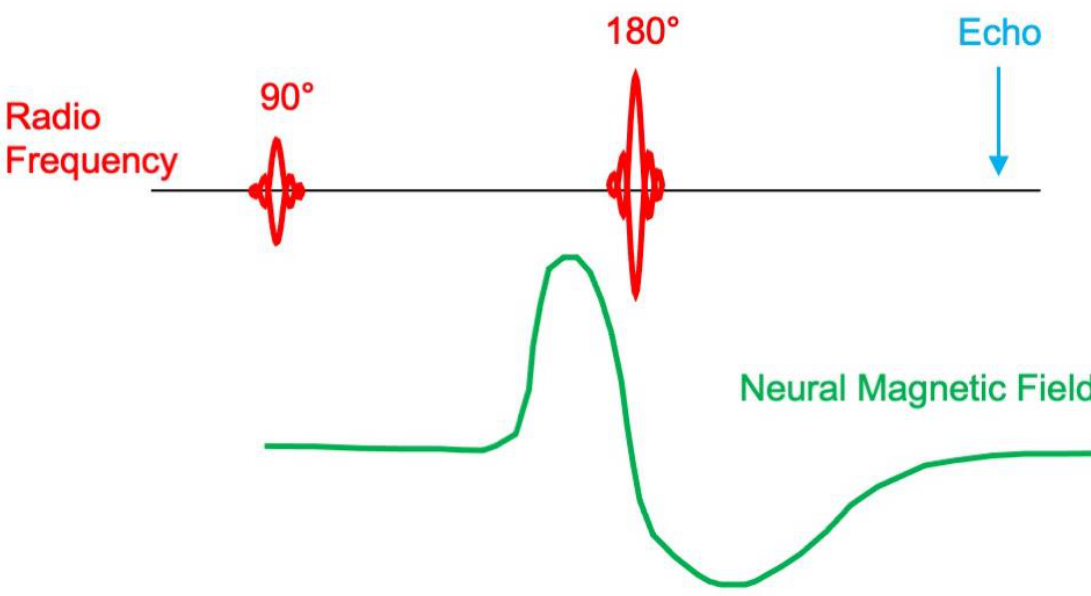
Figure 3. The optimum timing of the neural magnetic field waveform during a spin-echo pulse se- quence. The initial depolarization (positive) phase of the signal occurs before the 180° radiofre- quency pulse, and the repolarization (negative) phase occurs after it. In this case, the phase shifts all combine to produce the largest effect on the echo. Adapted from Figure 1 of [7].